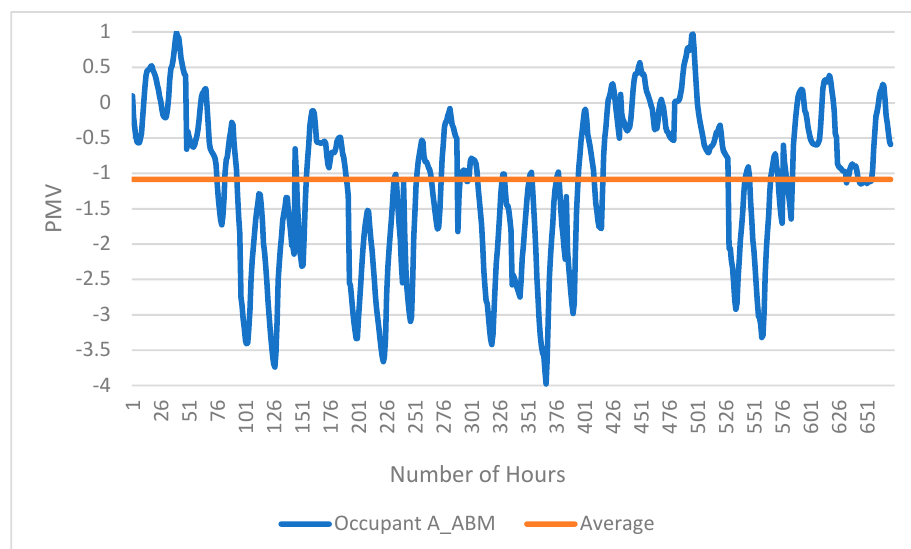
Figure 11. PMV fluctuation for occupant A in ABM–based simulation scenario.